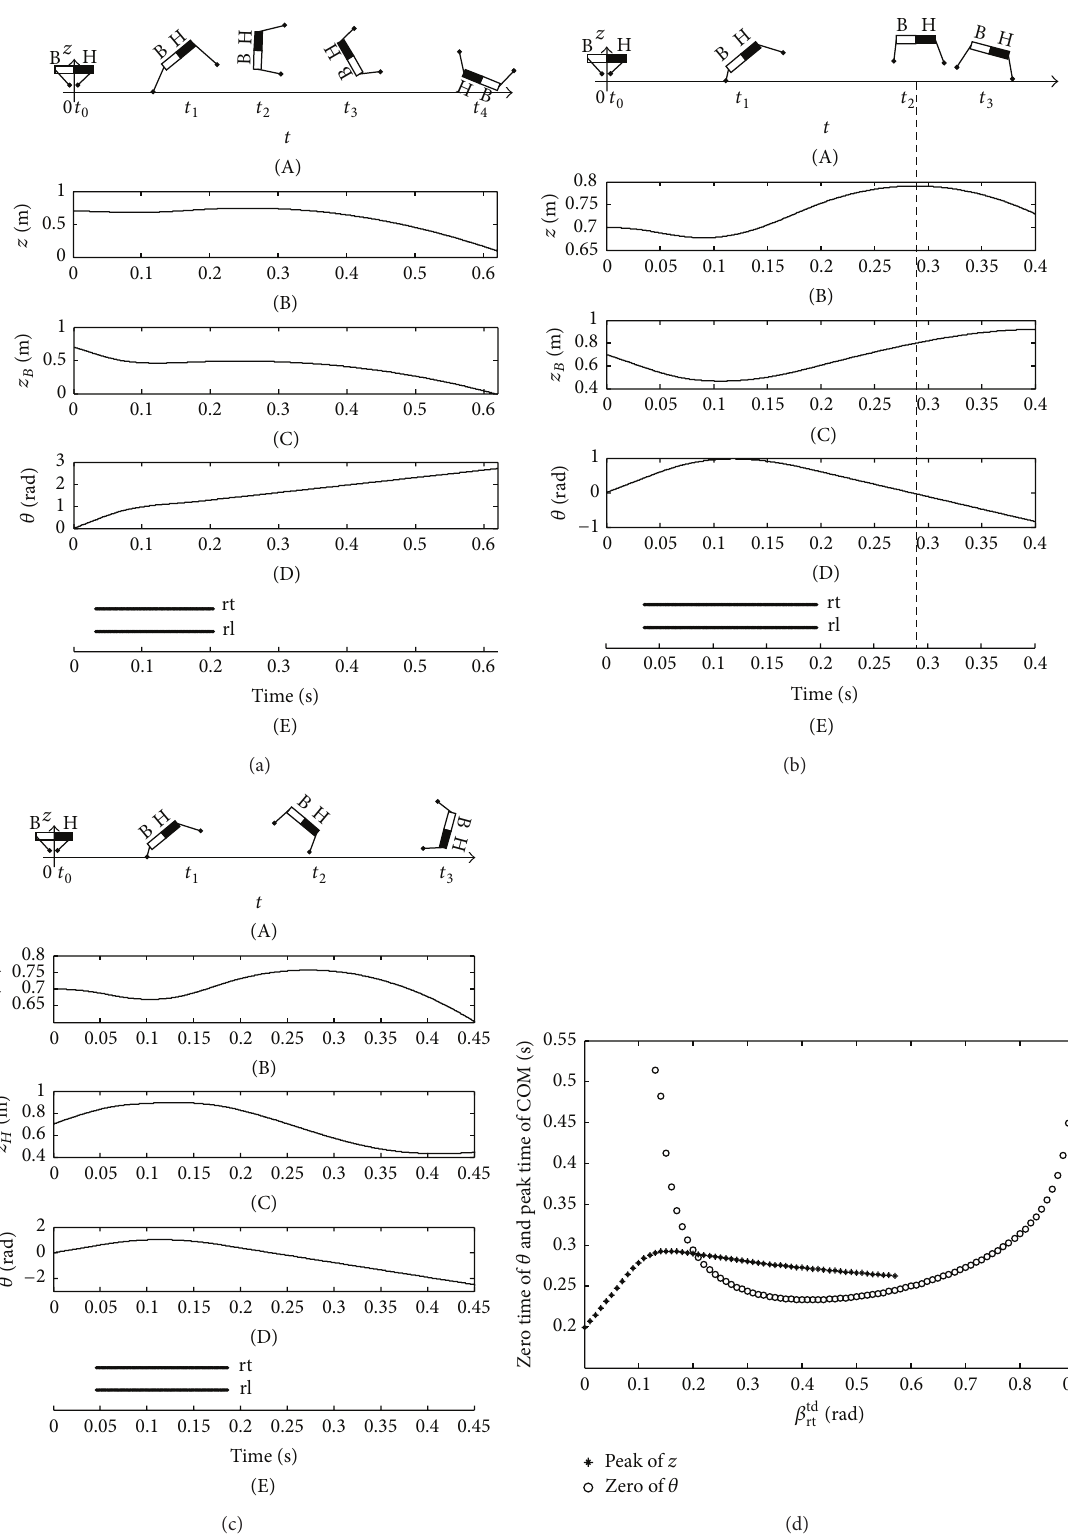
Figure 15: Imbalance and balance postures of greyhound. (a) The imbalance posture when 𝛽 td rt = 0 . 07 rad; (b) the balance posture when 𝛽 td = 0 . 21 rad; (c) the imbalance posture when 𝛽 td rt